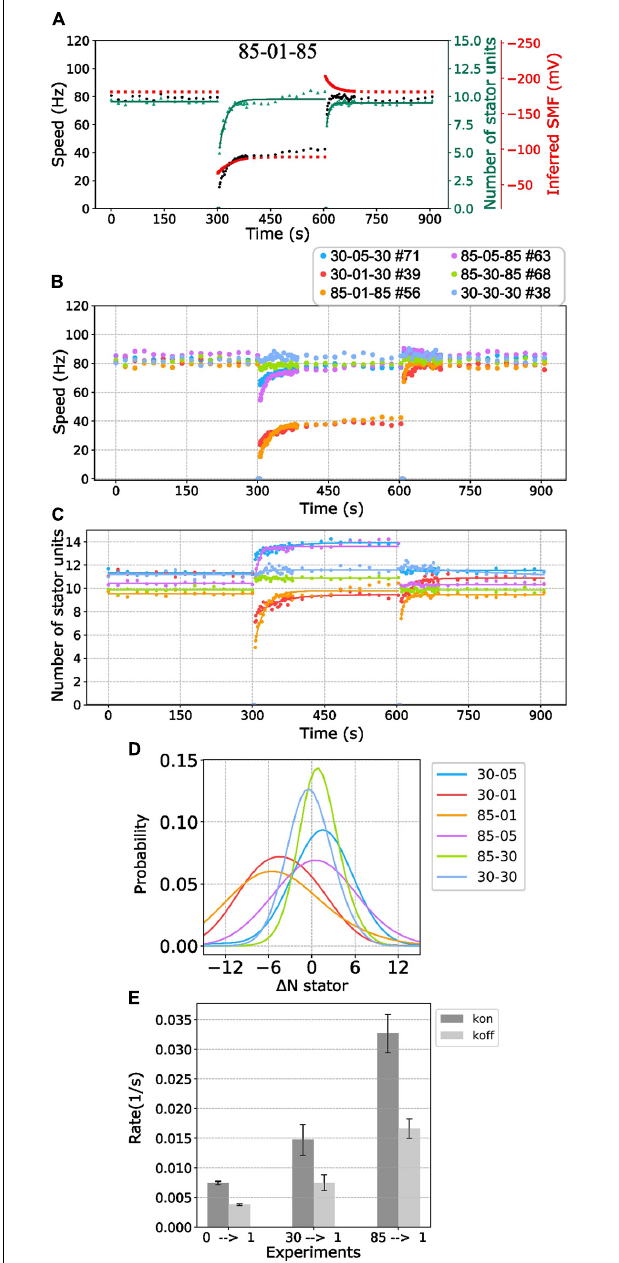
FIGURE 5 | BFM speed and stator number kinetics to nonzero [Na + ] ex . (A) Perfusion experiment of 85-01-85 mM sequence. The black dots show the average BFM speed. The red dots represent the inferred SMF. The green dots and line represent the number of stator units and its fitting result to the simple Hill–Langmuir absorption model. (B) BFM speed data collection of perfusion experiments from high to different nonzero different [Na + ] ex . The legend indicates the perfusion [Na + ] ex sequence and the number of BFM speed data collected. (C) The dots and lines show the number of stator units inferred from the speed results in B and the fitting results, respectively. (D) Kernel density estimate of the number of stator unit differences between step-down sodium perfusion. (E) The K on /K off for 0-1, 30-1, and 85-01 mM stator unit resurrection fitting results in C. The error bar is the standard deviation of the fitting